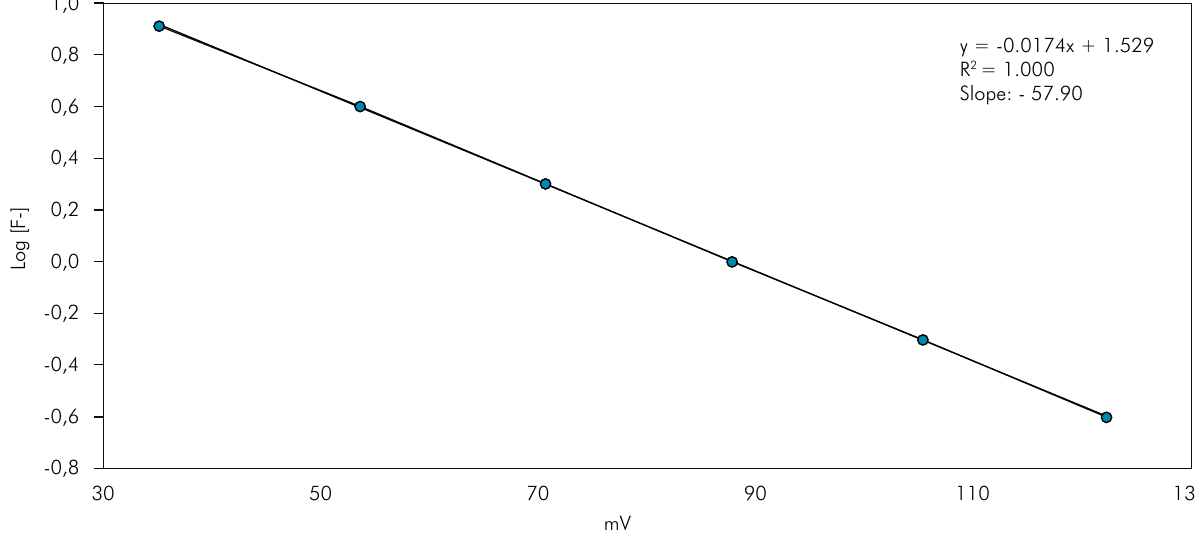
Figure. Calibration curve for correlation of the logarithm of fluoride concentrations in standards and the relative mV generated (mean = 9).